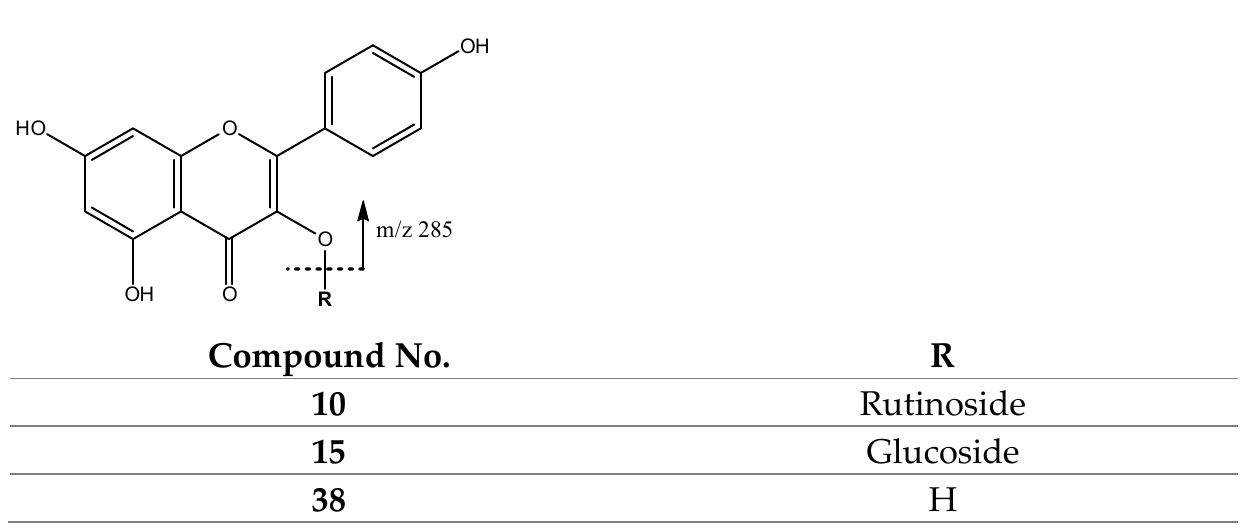
Figure 19. Myricetin fragmentation.